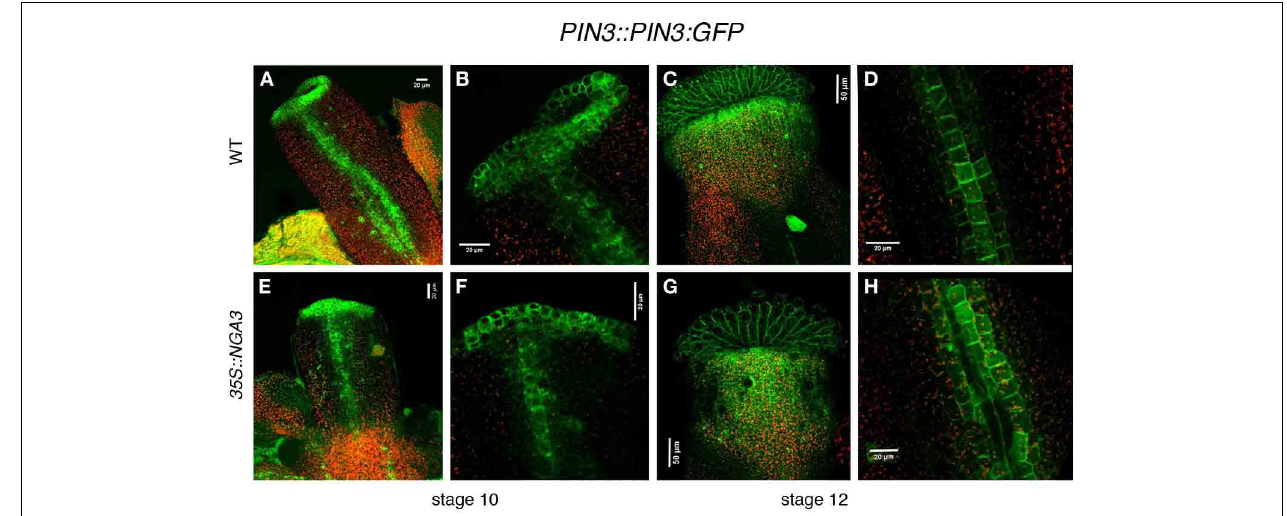
FIGURE 5 | Effect of NGA altered activity on PIN3 protein localization. PIN3::PIN3:GFP expression was observed in wildtype (A–D) and 35S::NGA3 (E–H) developing gynoecia at stage 10 (A,B,E,F) and stage 12 (C,D,G,H) . Close view of the apical ring in wildtype (B) or 35S::NGA3 (F) stage 10 pistils did not show a clear PIN3 subcellular polarization, although in the longitudinal stripes of cells running along the ovary, PIN3 appears to be predominantly at the basal side of cells. (C) Stage 12 wildtype gynoecia showed strong GFP